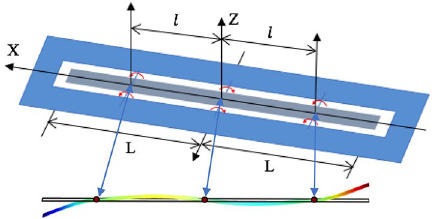
Figure 1. A mirror-symmetric profile of an elongated thin metal beam (the gray colored ribbon in the middle of a solid blue reference frame) which is hinged at three equally separated axes and having overhanging free ends. Such deformation profile also shown is the result of a linearly distributed force-per-unit-length, representing a pure gravity gradient